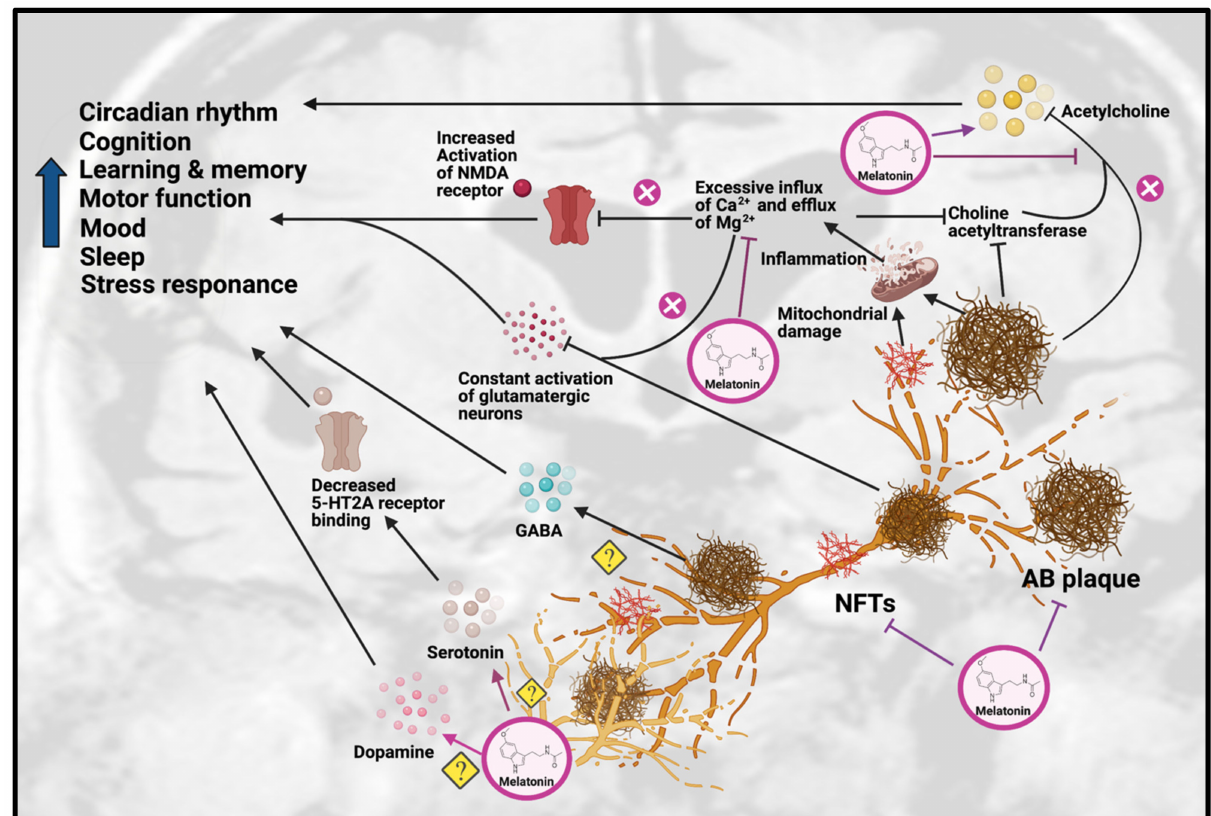
Figure 2. Effects of Melatonin treatment on dysfunction of neurotransmission in AD. Melatonin can ameliorate the formation of A β plaques and NFT, as well as improve the impairments due to these AD hallmarks, including disrupted circadian rhythm, cognition, learning, memory, motor function, mood, sleep and stress response. Melatonin treatment can have beneficial effects on serotonergic and dopaminergic systems, but the exact mechanisms have yet to be determined. Melatonin can also have beneficial effects on the cholinergic system by increasing acetylcholine release and reducing inflammation caused by excessive influx of Ca 2+ and excessive efflux of Mg 2+ , thereby inhibiting choline acetyltransferase. Abbreviations: A β , Amyloid-beta; NFT, neurofibrillary